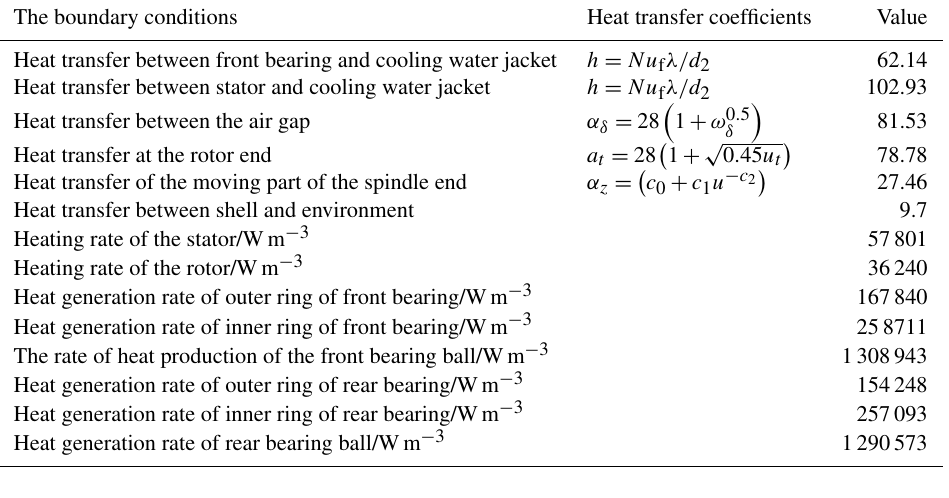
Table 1. Thermal boundary conditions and thermal model parameter.